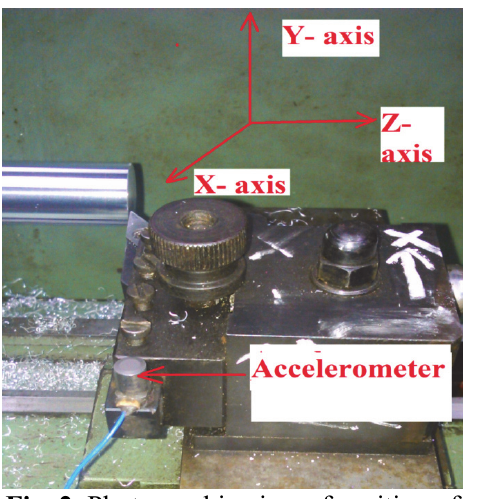
Fig. 3. Photographic view of stylus type profilometer, Talysurf